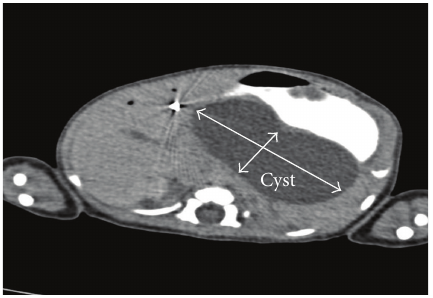
Figure 3: Cyst along posterior wall of